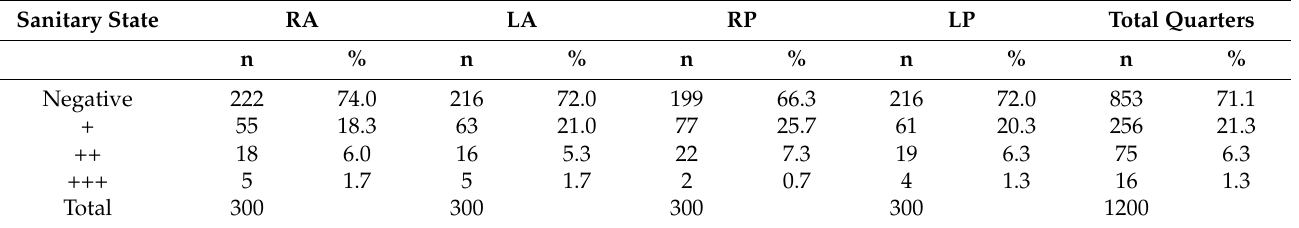
Table 4. California mastitis test positivity discriminated by individual mammary quarters, within the evaluated population of dual-purpose